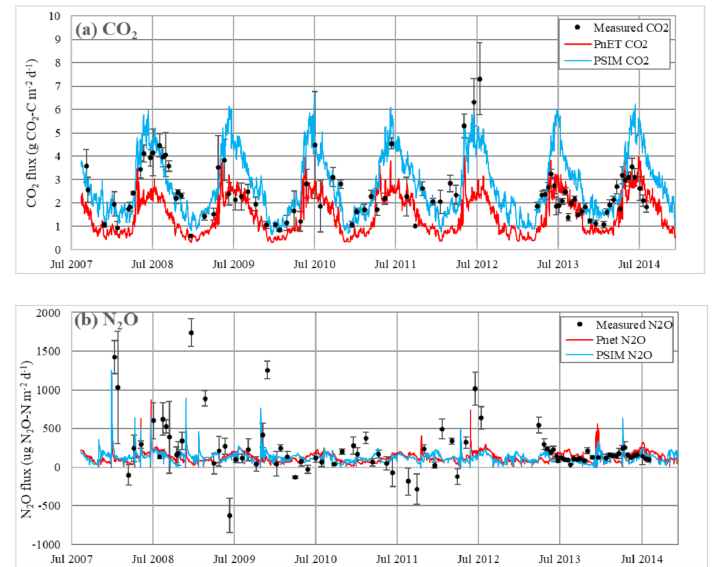
Figure 5. Daily soil fluxes simulated by LandscapeDNDC with PnET (red) and with PSIM (blue) and measured by chambers (black) at the Tower Site, Straits Inclosure; ( a ) CO 2 and ( b ) N 2 O. Standard error bars (for 6 chamber replication) shown on CO 2 and N 2 O measurements.